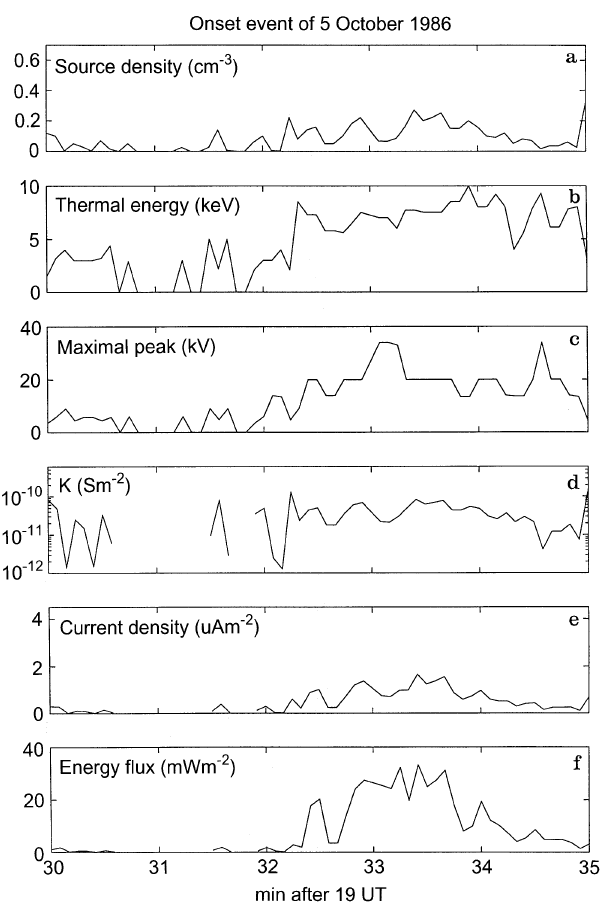
Fig. 3. a Source density, b thermal energy, c field-aligned conduc- tance, d potential drop, e current density and f energy flux esti- mated from each 5-s spectra during the 5 October 1986